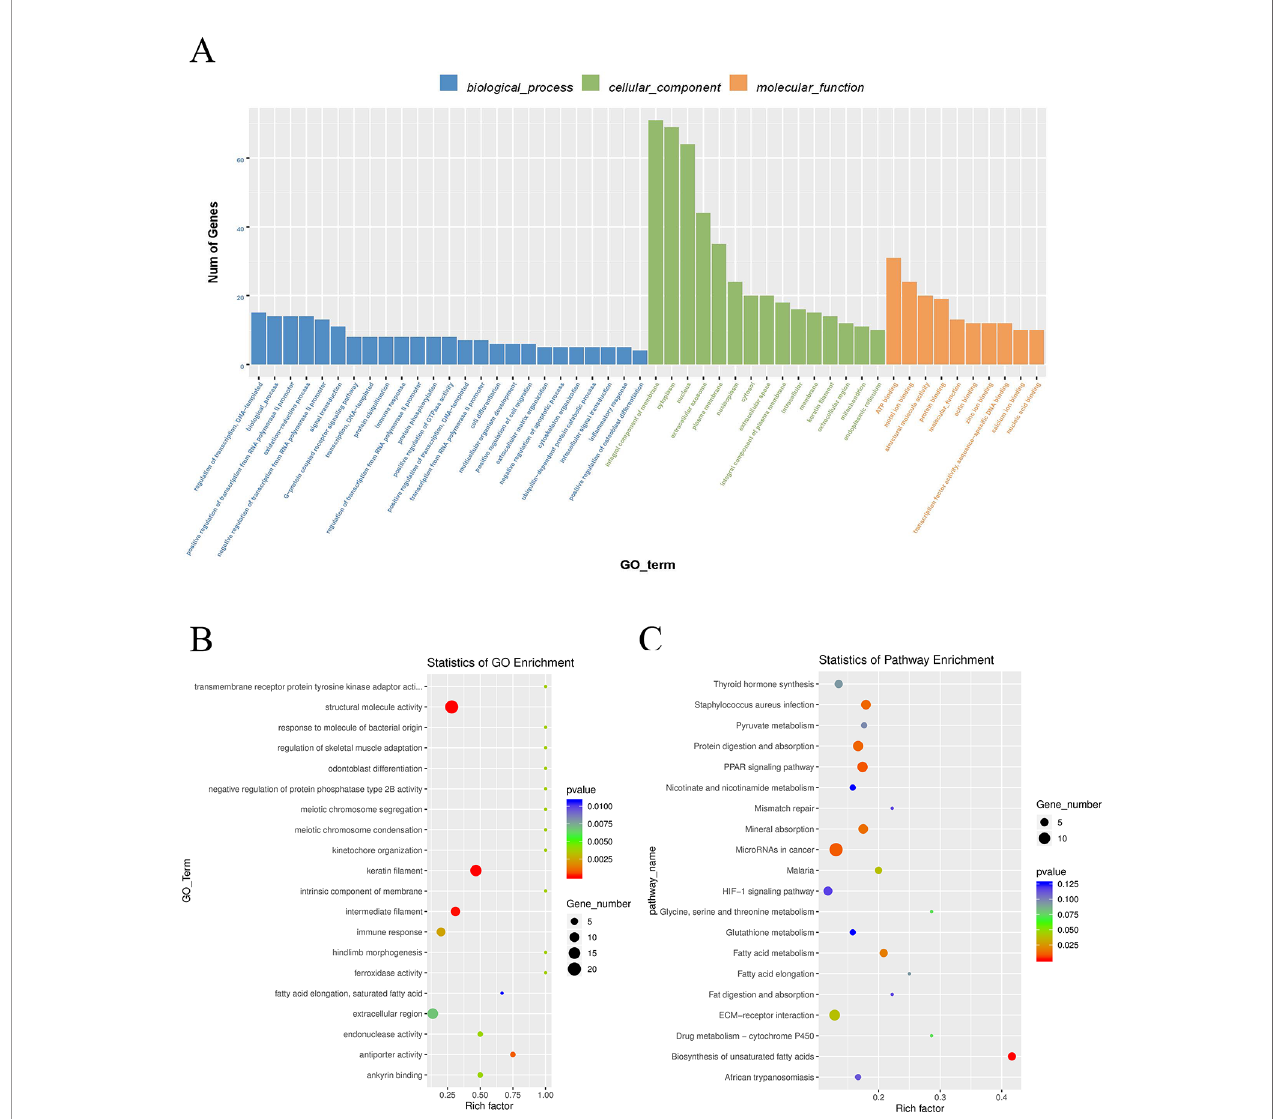
FIGURE 5 | Gene ontology enrichment and KEGG pathway analysis of differential m6A peaks. (A) Major enrichment and meaningful GO terms of m6A peaks. (B) The top 20 signi fi cantly GO enrichment terms. (C) The top 20 enriched pathways of m6A